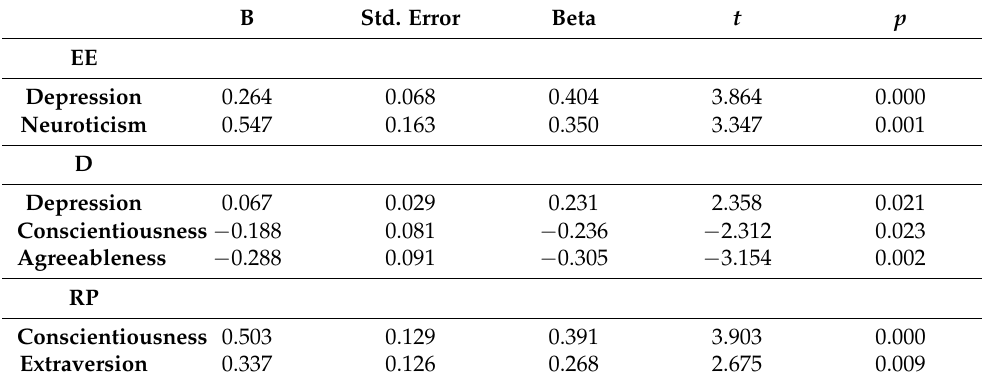
Table 6. Multiple linear regression between the burnout domains, personality factors, anxiety, and depression. B Std.